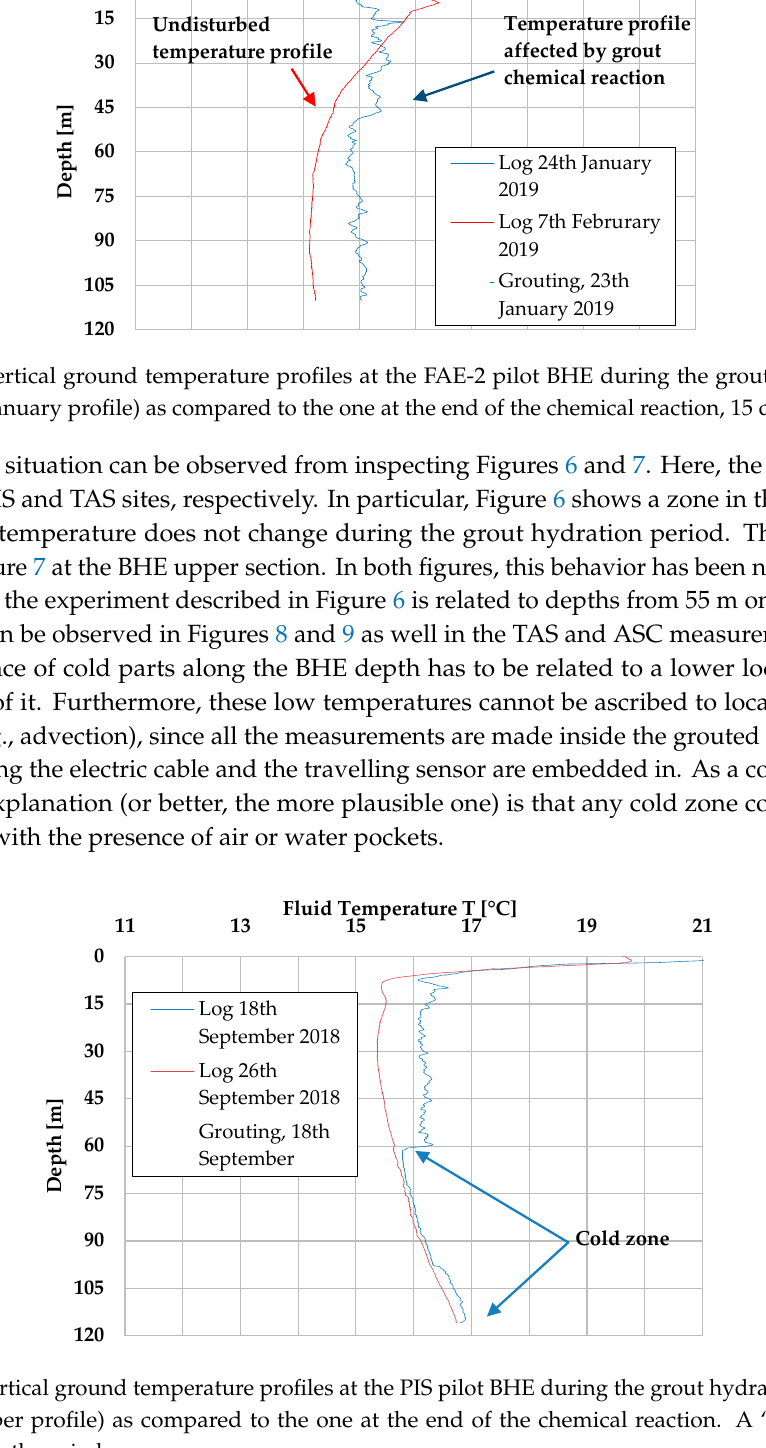
Figure 6. Vertical ground temperature profiles at the PIS pilot BHE during the grout hydration period (18 September profile) as compared to the one at the end of the chemical reaction. A “cold zone” appears at both